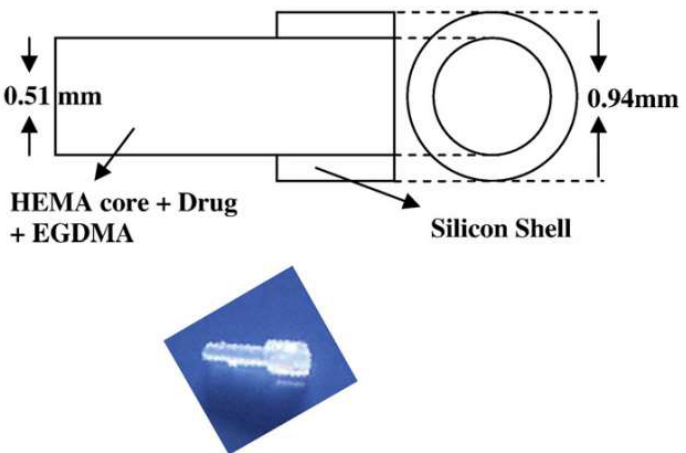
Figure 6. Schematic illustration for the preparation of FK506-encapsulated temperature-sensitive hydrogel. Reprinted from [91] under the CC BY-NC-ND license.